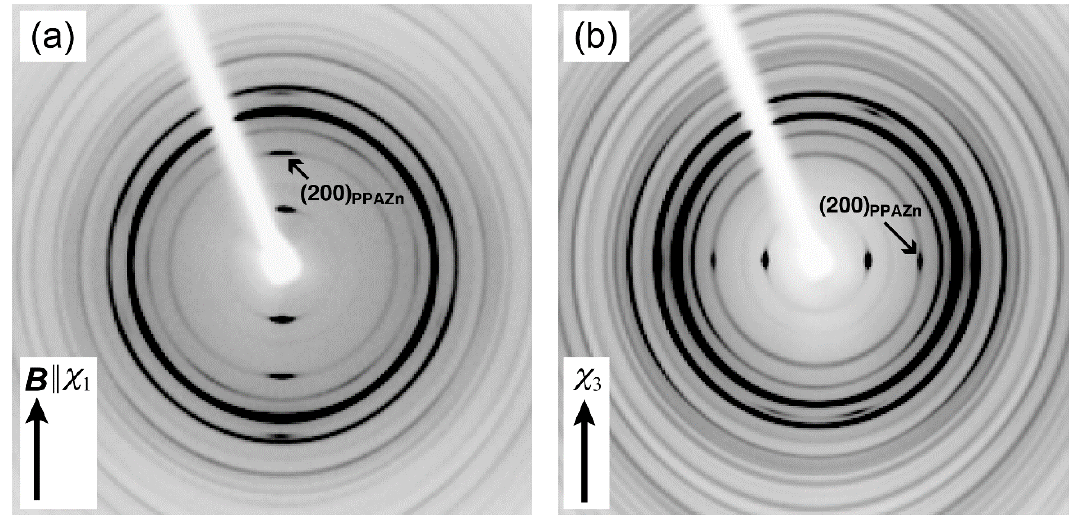
Figure 7. 2D-WAXD patterns of ( a ) PPAZn/PLLA-8TS, and ( b ) PPAZn/PLLA under the 8-T rotating magnetic field (PPAZn/PLLA-8TR). The X-rays were impinged perpendicular to the χ 1 -axis and χ 3 -axis for ( a ) and ( b ), respectively, of the PPAZn crystal.